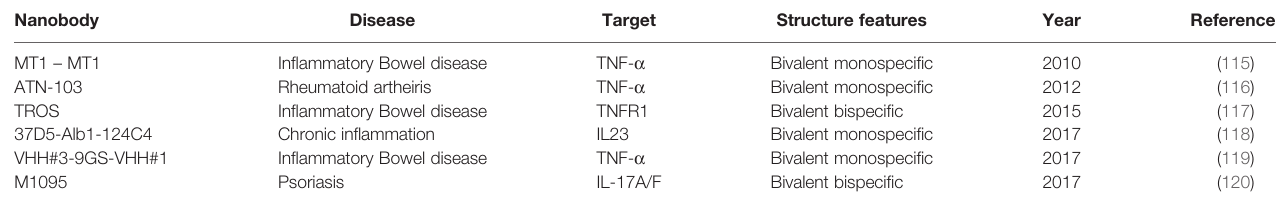
TABLE 3 | Multivalent mono/bispeci fi c nanobodies for autoimmune diseases.